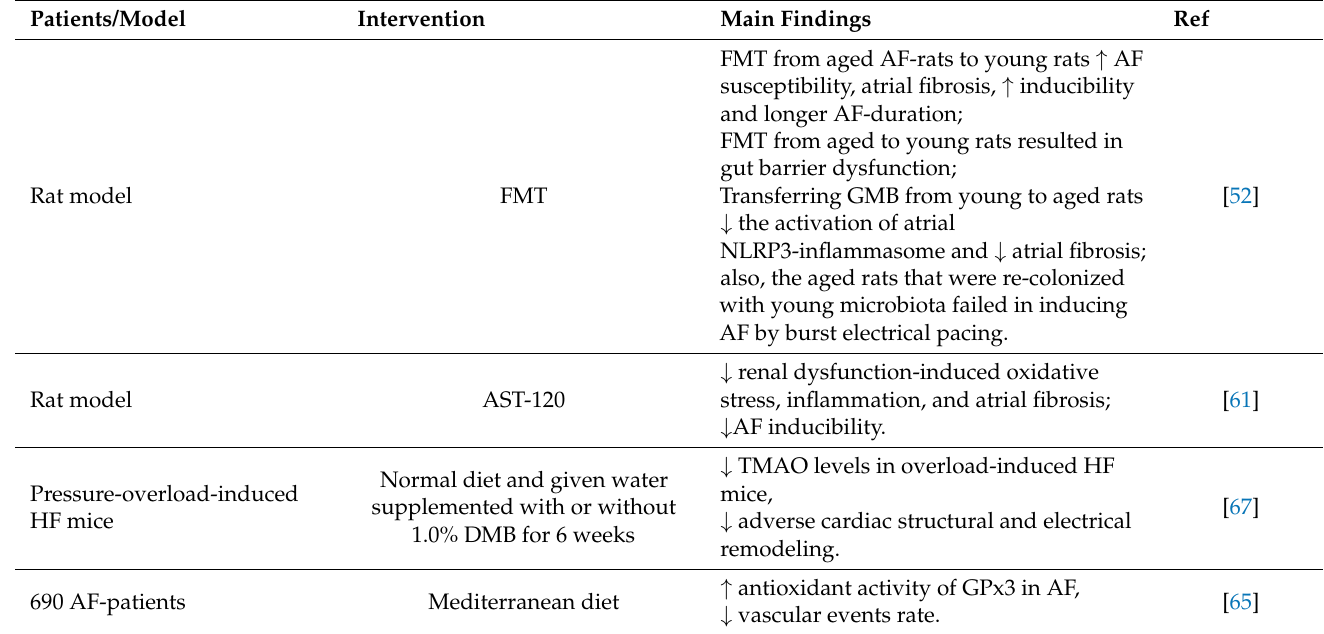
Table 2. The main results of studies on manipulation of gut microbiota in atrial fibrillation.